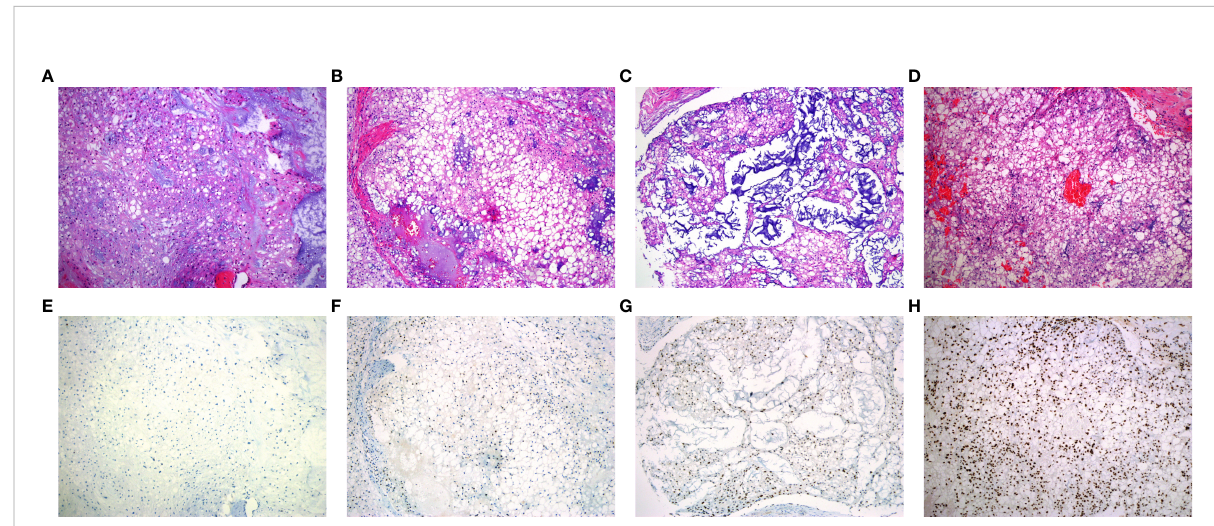
FIGURE 1 Representative patterns of H3K27me3 staining in conventional chordoma tissue microarray. (A-D) HE stained tissue sections. (E, F) Low expression of H3K27me3 in conventional chordoma. (E) All tumor cells with no staining, (F) 10% tumor cells with moderate staining. (G, H) High expression of H3K27me3 in conventional chordoma. (G) 70% tumor cells with moderate staining, (H) all tumor cells with distinct and strong brown